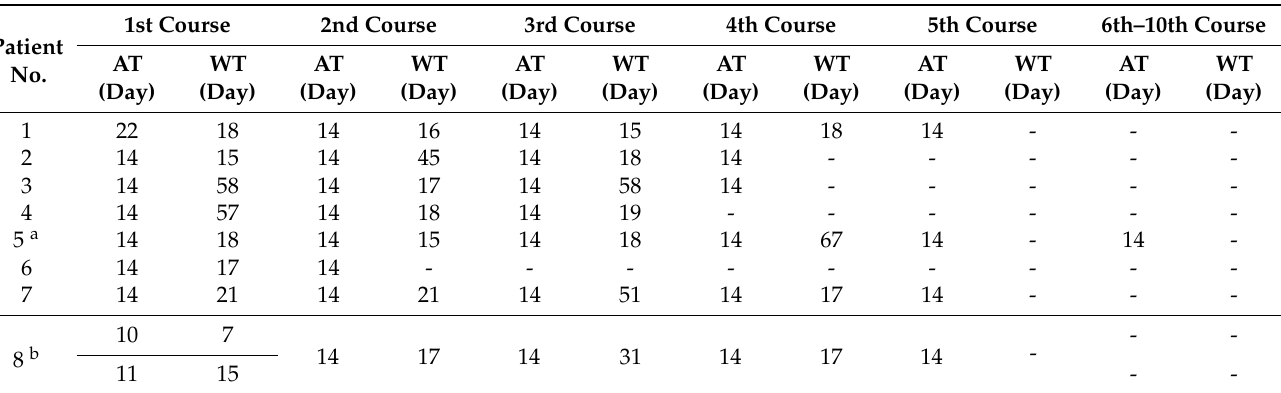
Table 1. Detailed medical profiles of all